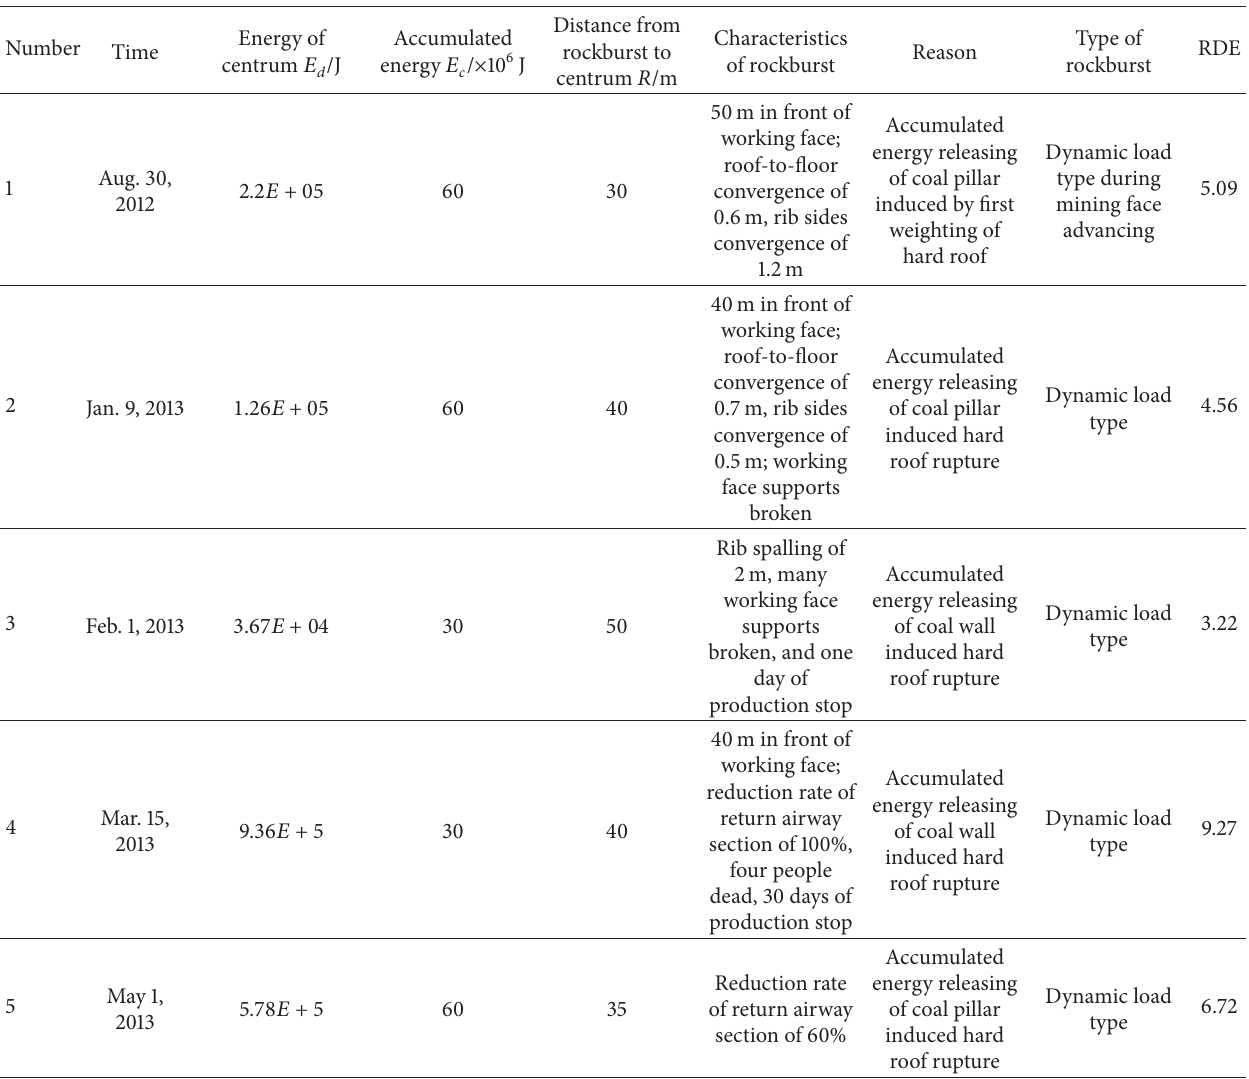
Table 5: Characteristics of